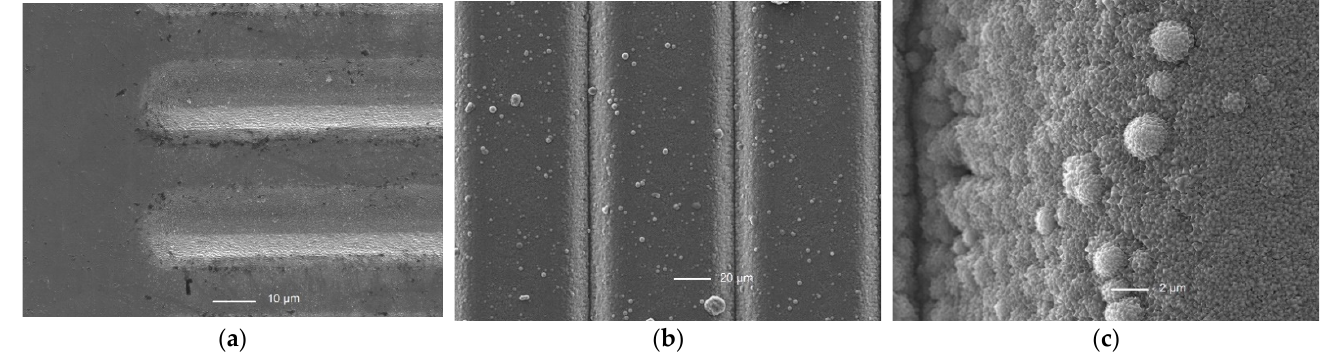
Figure 2. Laser-ablated steel surfaces: ( a ) after directional ablation, ( b ) and ( c ) bi-scale structure of isotropic pyramids on laser-ablated surfaces.